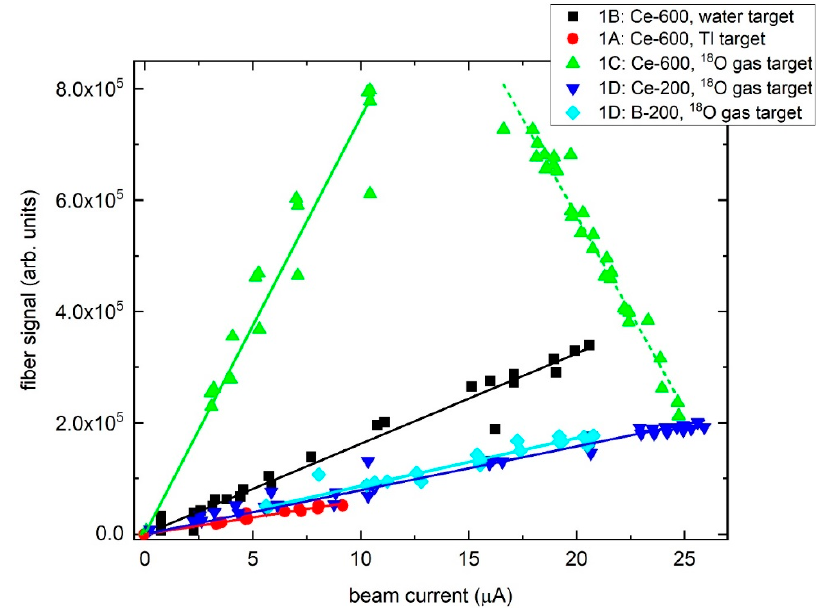
Figure 3. Response of the different fibers to changing beam current for different experiments. The R 2 values of the linear fits are (1B) 0.9968, (1A) 0.9661, (1C ascending) 0.9397, (1C descending) 0.9905, (1D Ce-200) 0.9929, and (1D B-200) 0.9905, respectively.